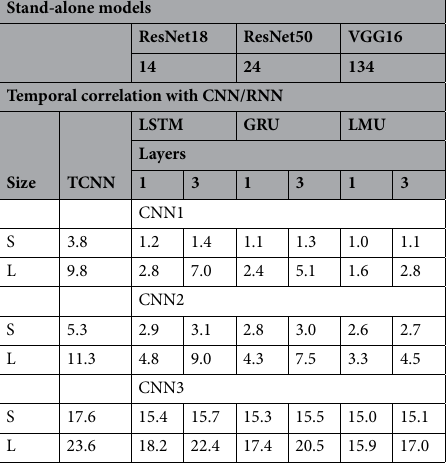
Table 2. Model complexity. Total number of trainable parameters (in Millions) for different models.